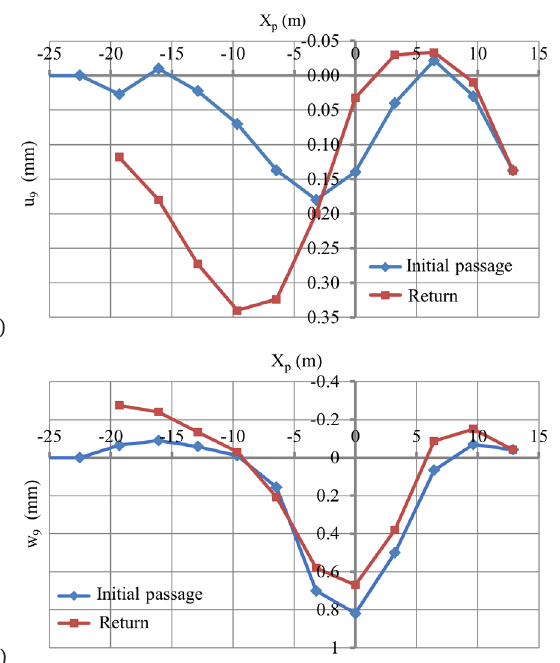
Figure 6: Horizontal (a) and vertical (b) displacement of point 9 during the loading test.